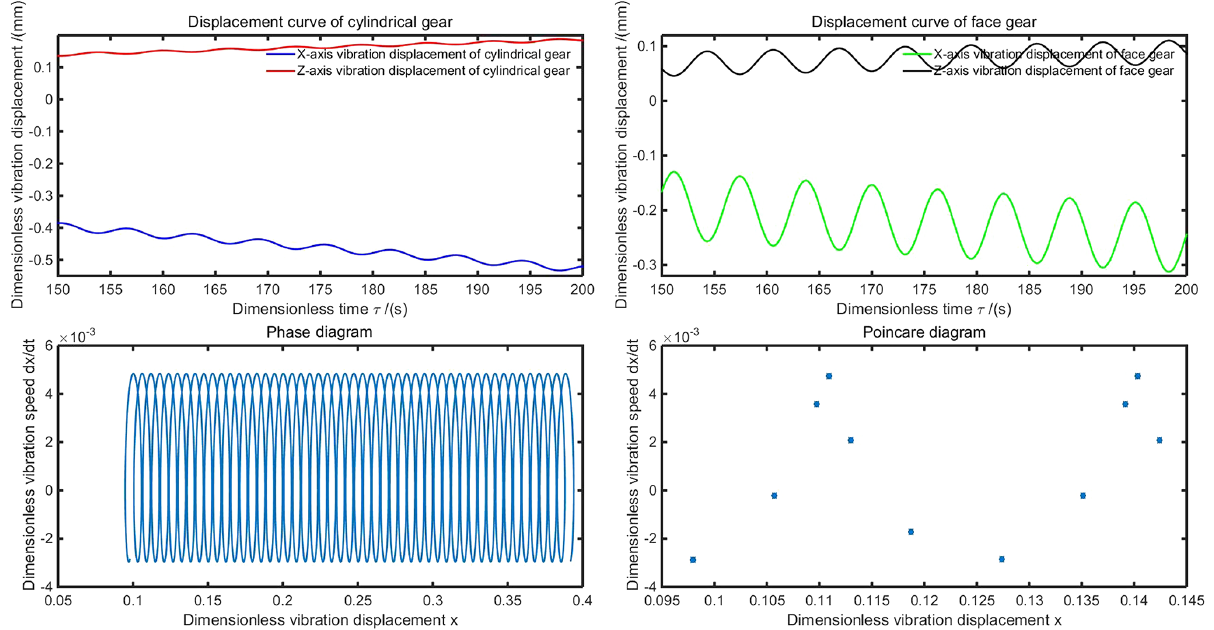
Figure 12. Displacement, phase, and Poincare diagrams of comprehensive meshing stiffness 4 . 5731 × 10 7 Nm − 1 .